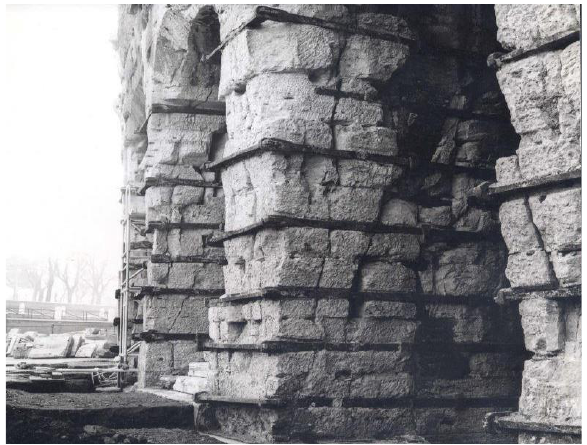
Figure 4. Image related to the retrofit interventions carried out in the 1970, that shows the state of the columns.